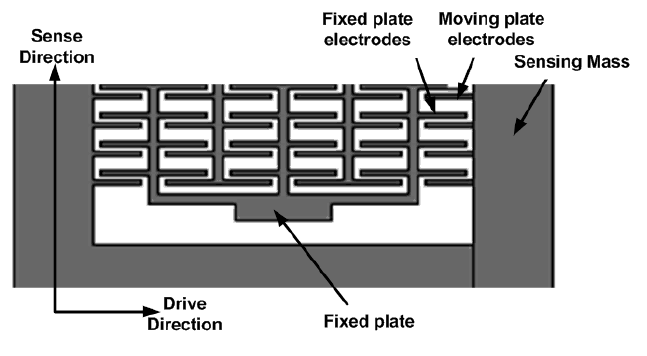
Figure 19. Capacitive detection mechanism using parallel